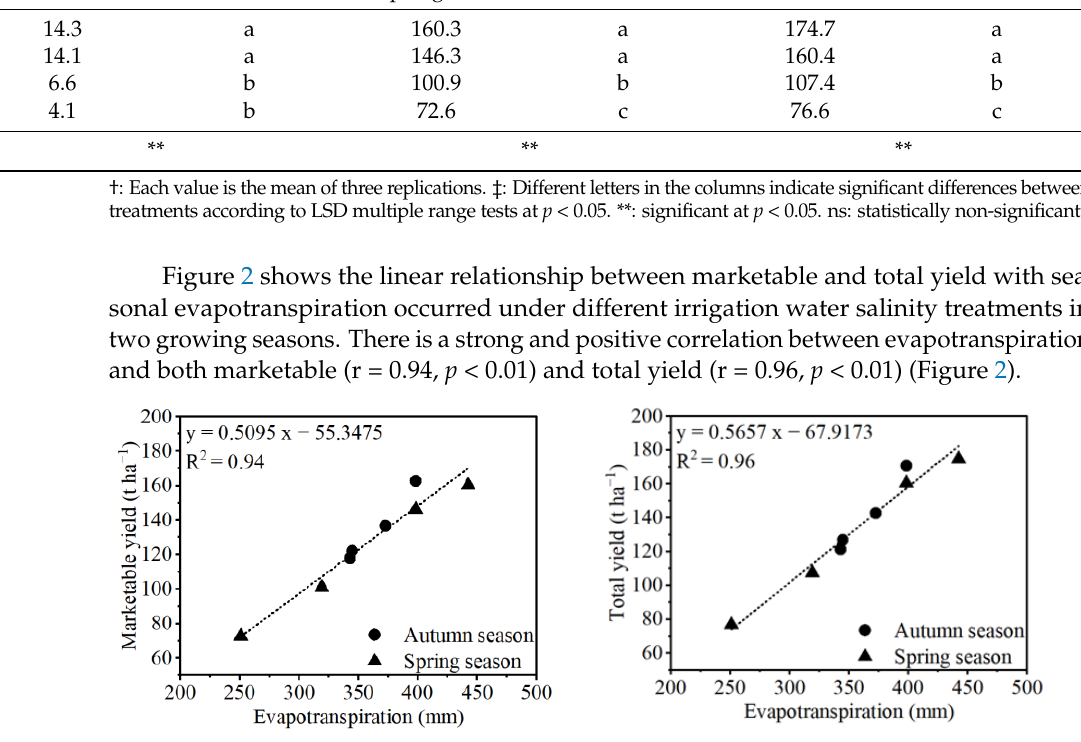
Figure 2. Linear relationship between marketable yield and total yield with seasonal evapotranspiration at different salinity levels in two different growing seasons.